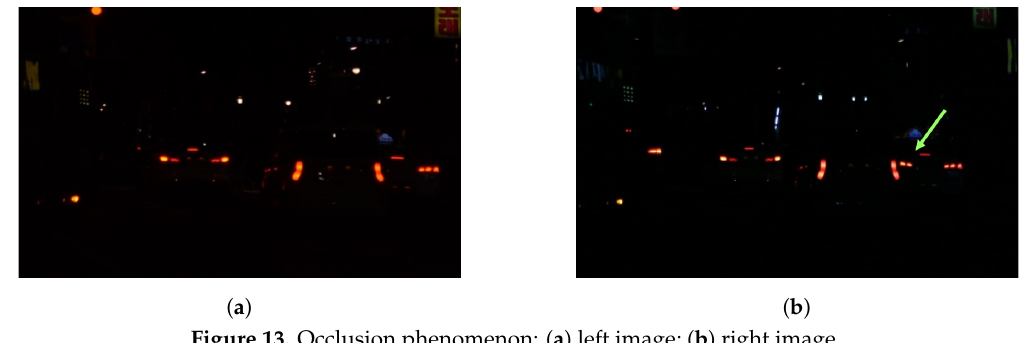
Figure 13. Occlusion phenomenon: ( a ) left image; ( b ) right image.